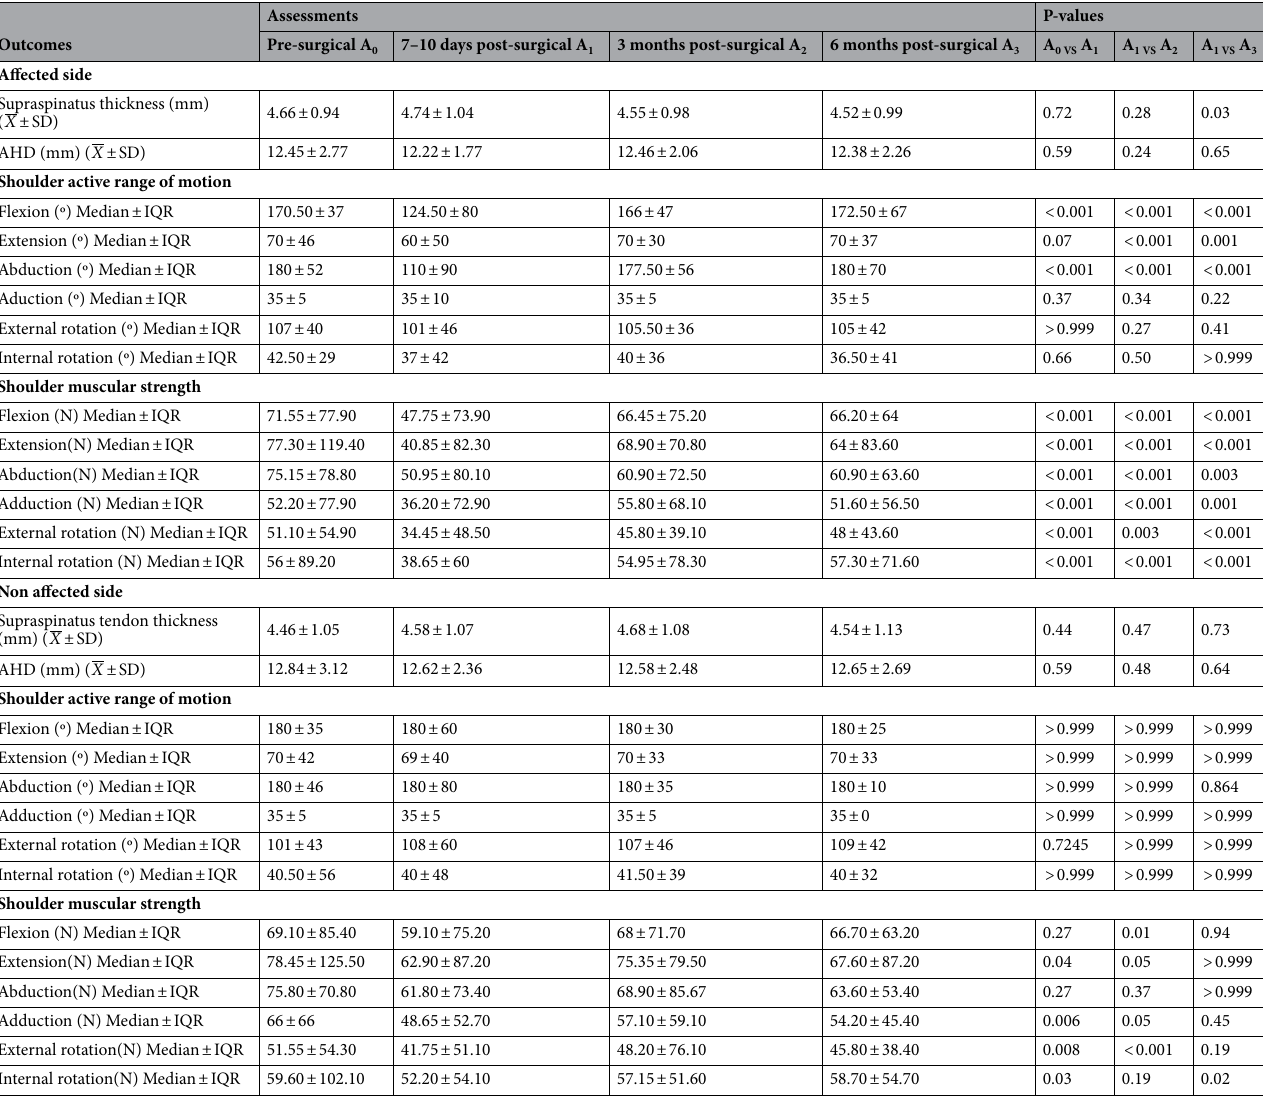
Table 2. Shoulder outcomes between baseline measurement and different follow-ups. X mean, SD standard deviation, AHD Acromiohumeral distance, IQR interquartile range, N Newtons.